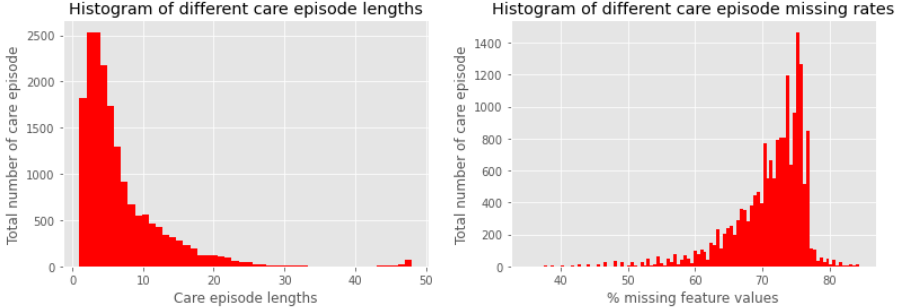
Figure 1. A care episode having with 48 time-window s ( care episode length = 48).